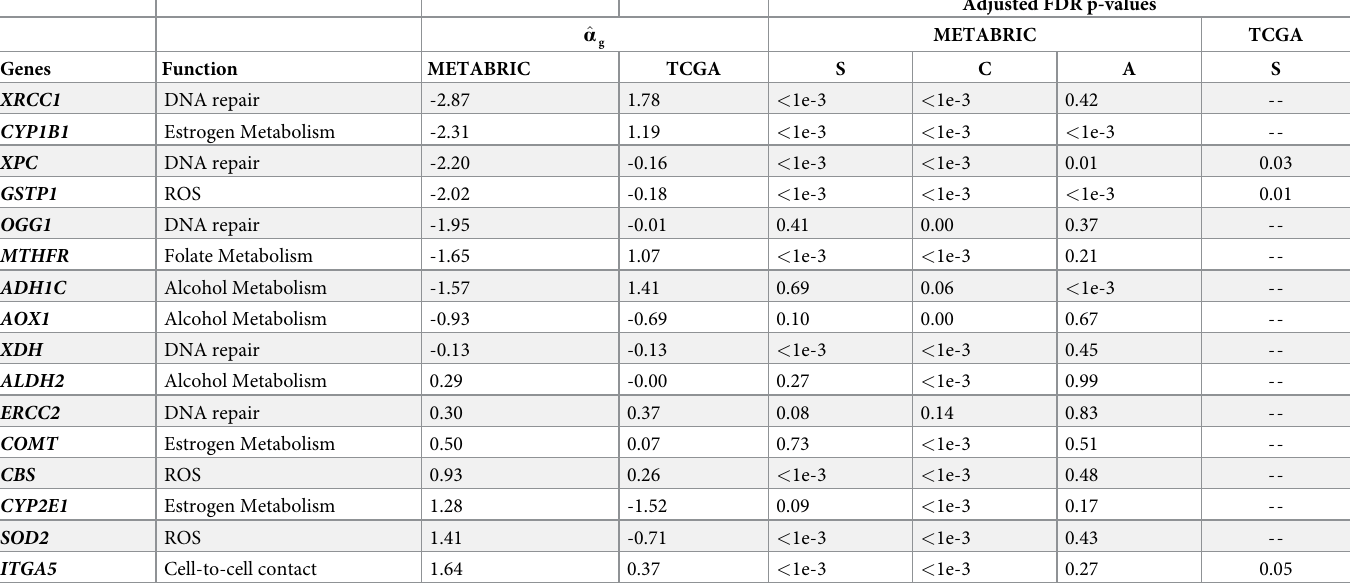
Table 1. ANOVA results for the expression of genes related to alcohol metabolism. HUGO gene names and functions are presented along with gene expression effect on survival ( ^ α ). The effect shows if the gene was up- or down-regulated in tumors from deceased patients at the fourth year. The p-values for a two-way ANOVA (FDR- g adjusted across all genes) are also shown. ANOVA tests considered the effect of gene expression on vital status (S), cancer subtype (C), and patients age (A). Same models were validated on breast cancer data from The Cancer Genome Atlas (TCGA).